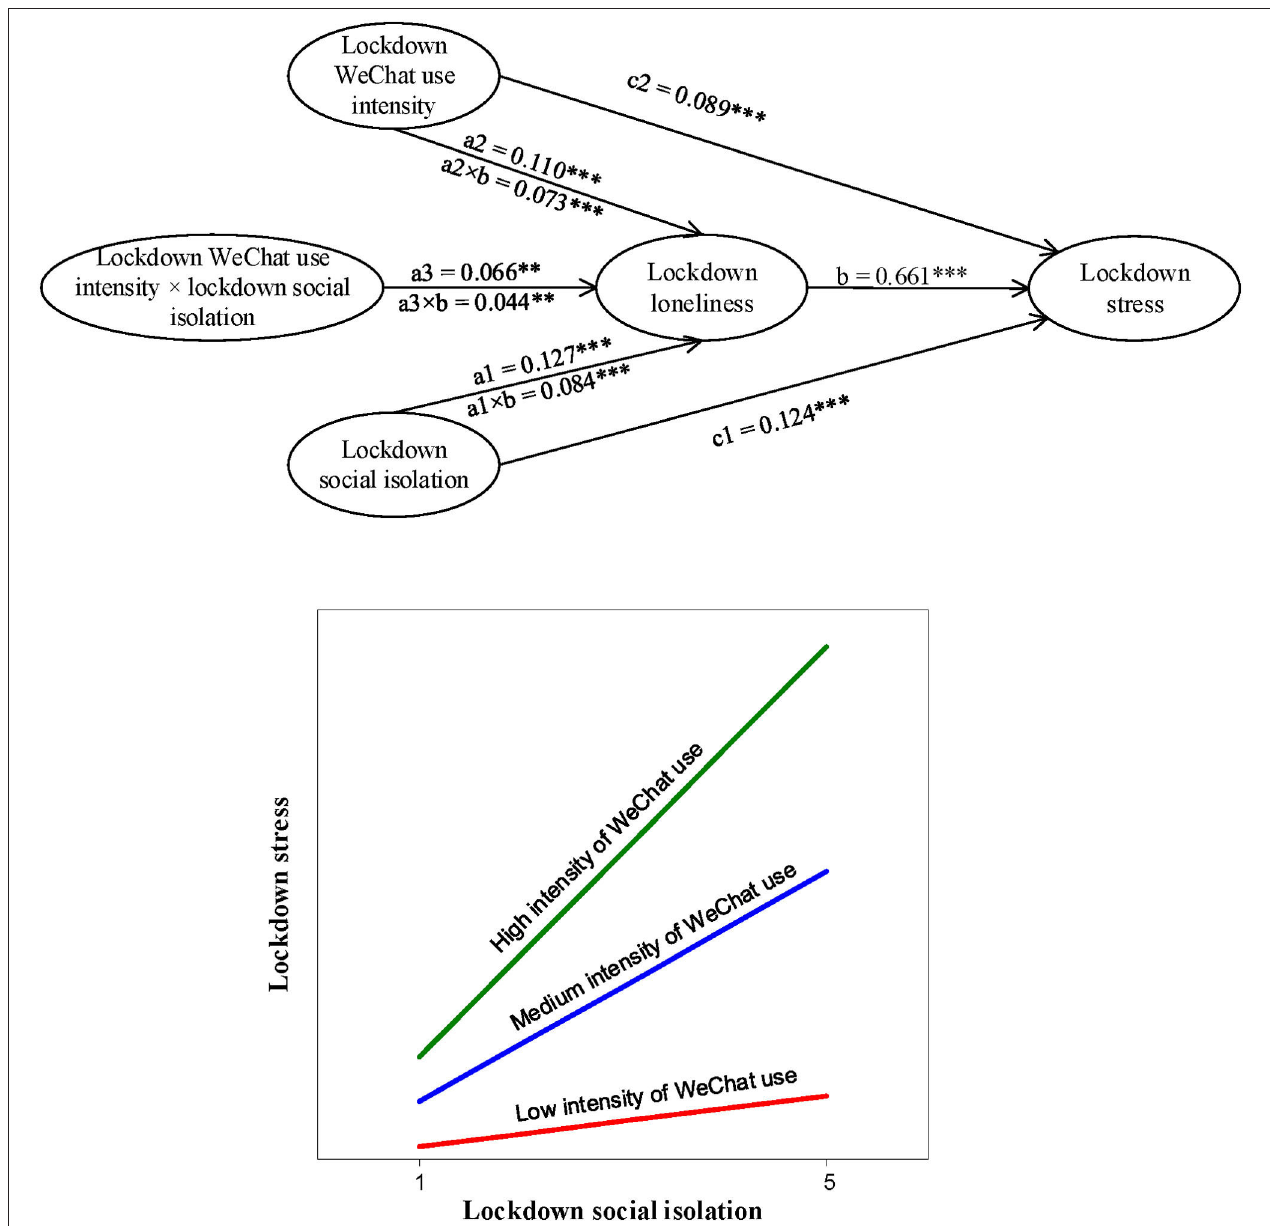
FIGURE 2 | A graphical illustration of parameter estimates and moderation by intensity of WeChat use (lockdown stress as dependent variable). Number of Free Paramaters = 59, LL = − 33208.532, AIC = 66535.063, ** p < 0.01, *** p < 0.001, n = 1805. Note.—The indirect effect of Lockdown Social Isolation on Lockdown Stress is conditional on Intensity of WeChat Use: (a1 × b) + (a3 × b) × Lockdown WeChat use